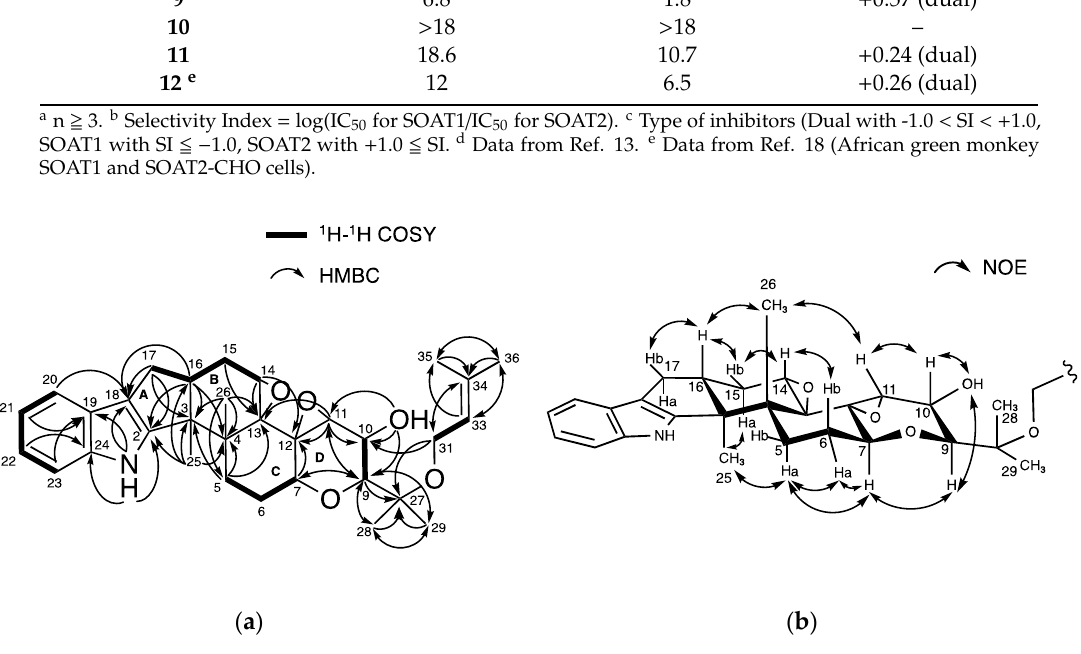
Table 3. Inhibitory activities of 1 – 12 on human sterol O -acyltransferase (SOAT)1 and SOAT2 activities in cell-based assays. Compound.